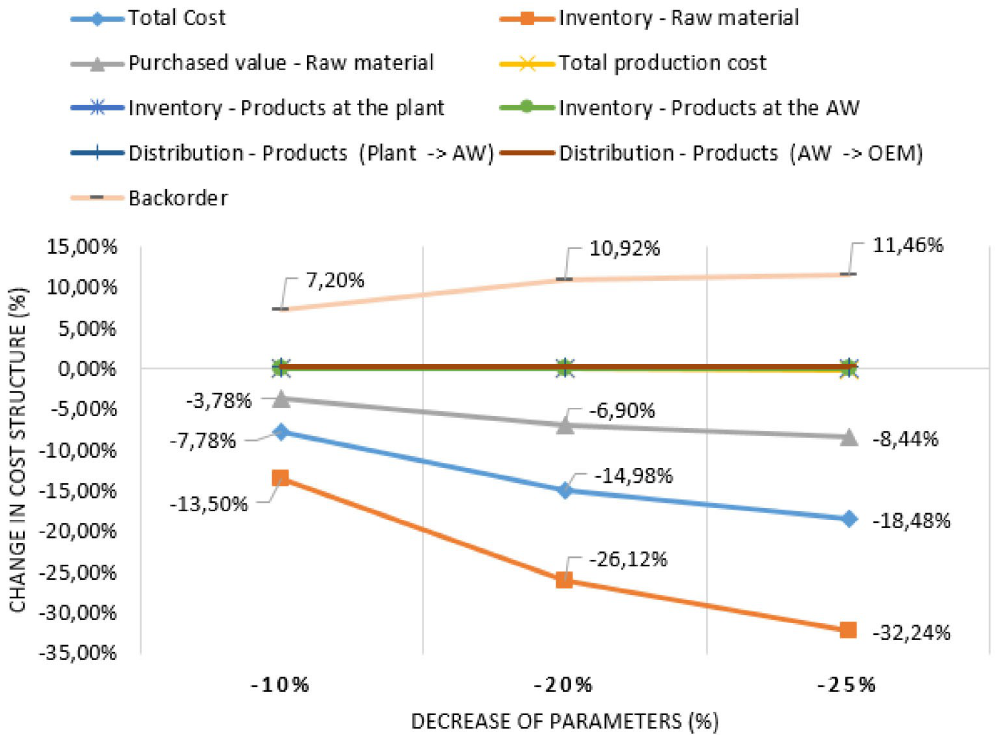
Figure 6. Objective function cost